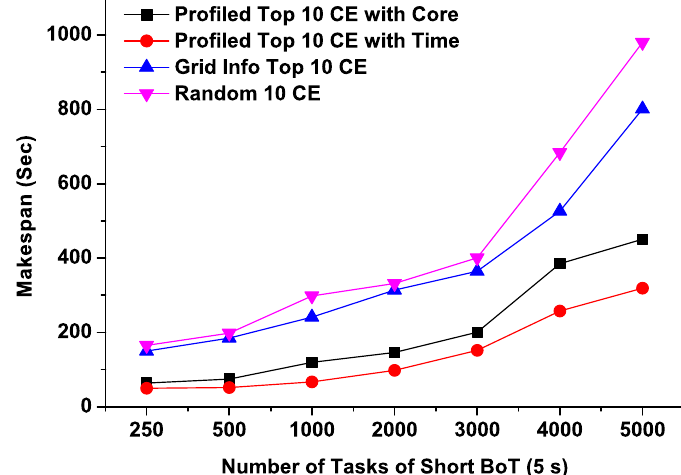
Figure 7. Makspans of Short BoT jobs with four sets of computing resources.